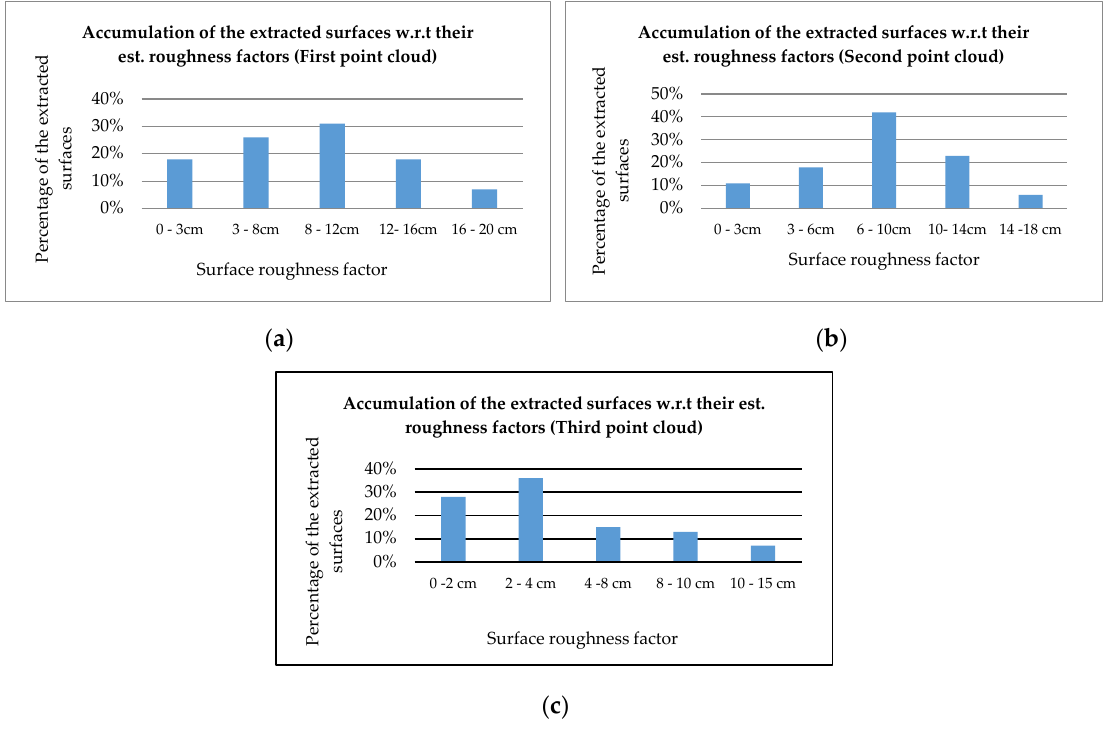
Figure 29. Analysis of the quality of the extracted surfaces from: ( a ) first; ( b ) second; and ( c ) third provided laser scanning point clouds after quality control of segmentation/planar surface extraction outcome.